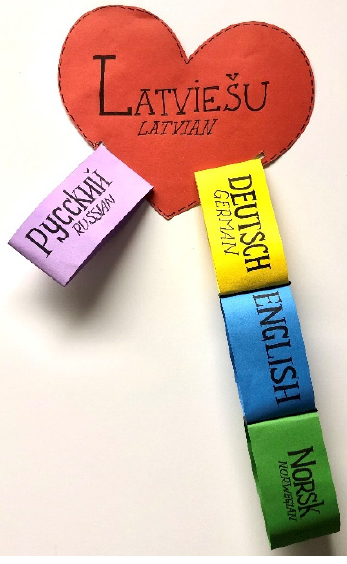
Figure 4. ST8’s DLC artefact.